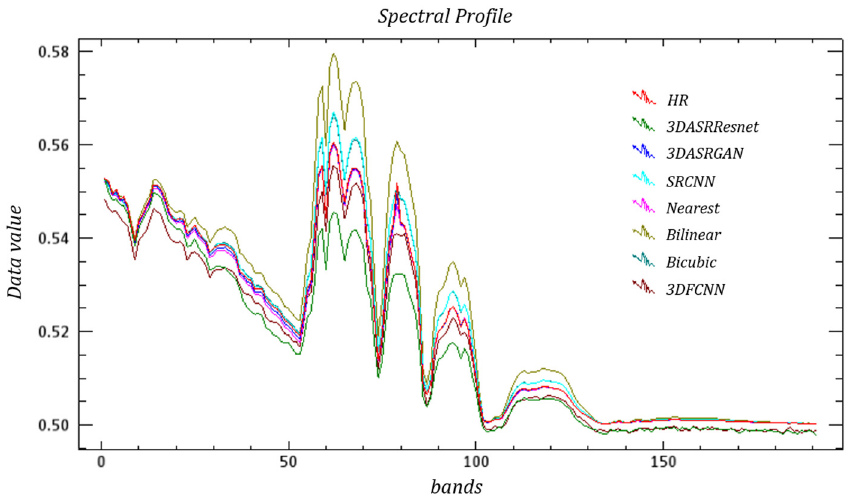
Figure 9. Example Spectral Curves of Grass based on Washington DC Mall dataset.